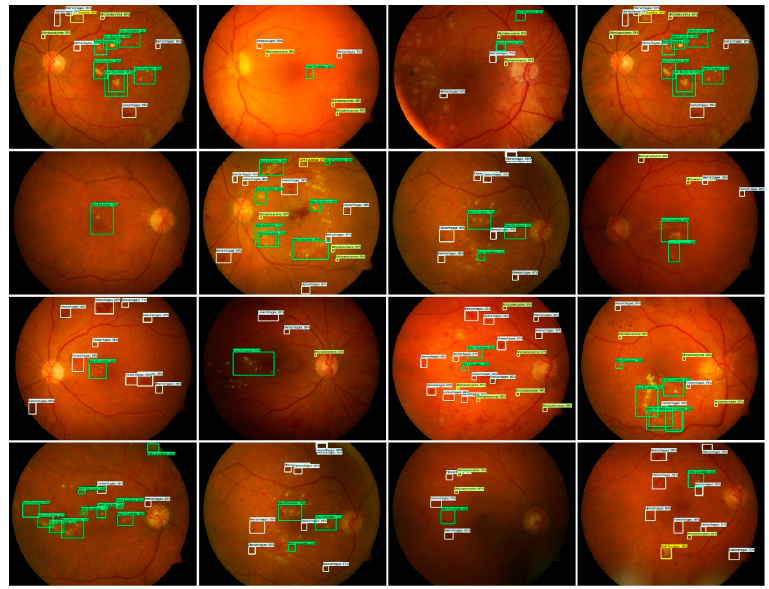
Figure 3. Test results of DR.